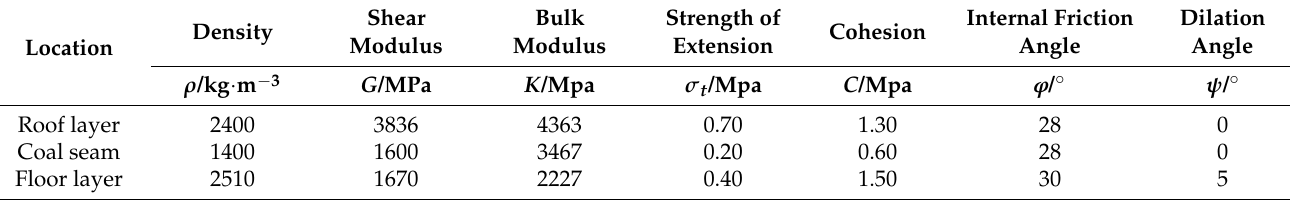
Table 1. The mechanical parameters of the surrounding rock mass and coal.